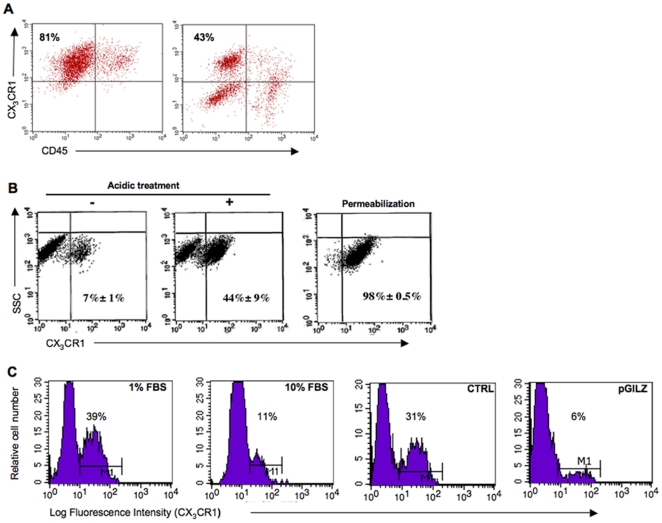
Expression of CX3CR1 in ovarian epithelial malignant cells.(A) Levels of CX3CR1 and of the pan-hematopoietic marker CD45 were determined by flow cytometry in 2 freshly dissociated samples of EOC specimens. Numbers indicate frequencies of CX3CR1+ CD45− cells. (B) Representative FACS profiles for CX3CR1 levels in BG1 cells. Left, surface expression of CX3CR1 under basal conditions; middle, surface expression of CX3CR1 in cells after acidic treatment; right, expression of CX3CR1 in permeabilized cells. Numbers indicate percentage of CX3CR1+ cells (mean ± SEM) for 3 independent experiments. (C) Histograms show the fluorescence intensity of CX3CR1 staining at the surface of CTRL BG1 cells cultured in the presence of 1% or 10% FBS, and of CTRL and pGILZ BG1 cells cultured in the presence of 1% FBS. Numbers indicate the percentage of CX3CR1+ cells for one representative experiment out of three.